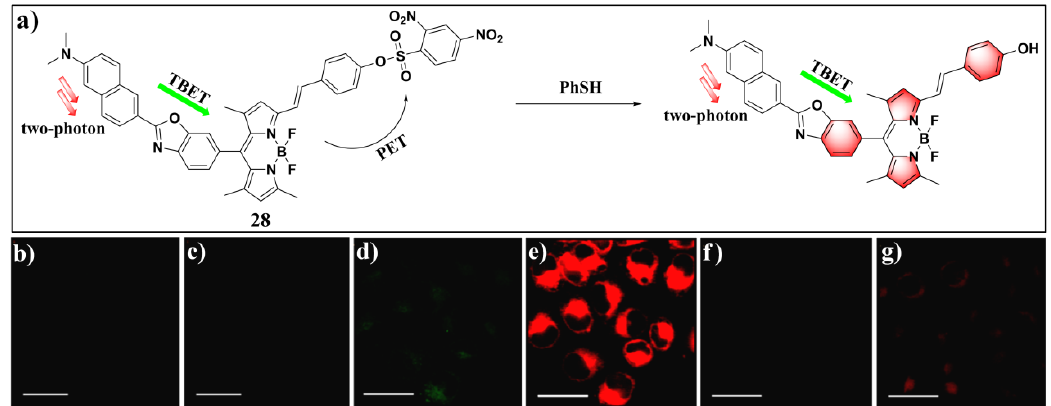
Figure 12. ( a ) Structure and reaction of probe 28 with PhSH. ( b , d , f ) Thymidine phosphorylase (TP) images of probe 28 in Hela cells from the green channel without thiophenol, with thiophenol, and with both NEM (N-ethylmaleimide) and thiophenol, respectively. ( c , e , g ) are corresponding TP images of ( b , d , f ) from the red channel, respectively. Reproduced with permissions from [89]. Copyright American Chemical Society.